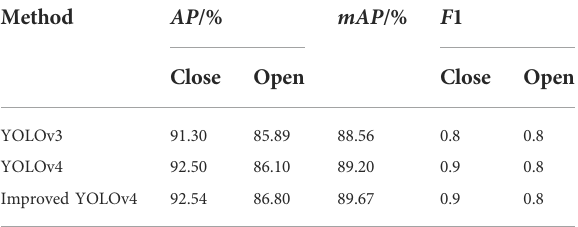
TABLE 1 Comparison of identi fi cation effects of different network